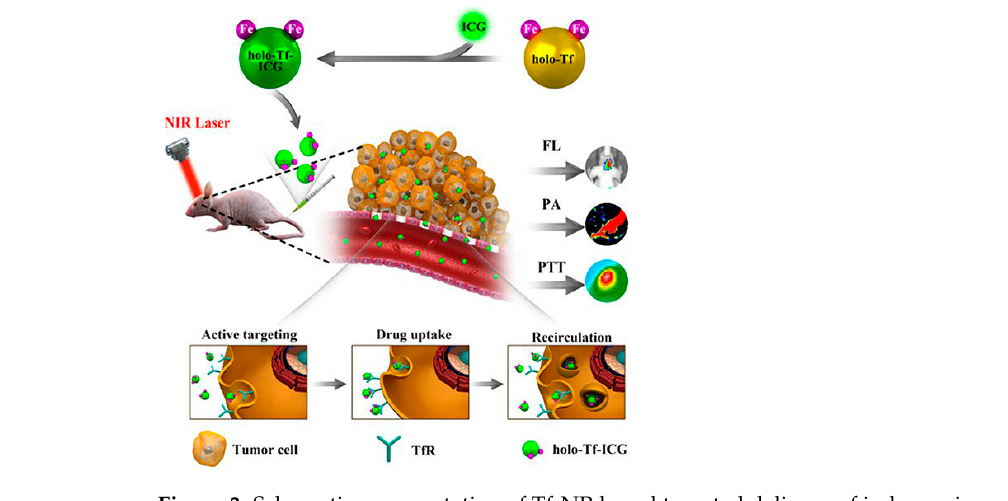
Figure 3. Schematic representation of Tf-NP-based targeted delivery of indocyanine green (ICG) for PTT. Reprinted with permission from [72]. Copyright 2017, American Chemical Society.